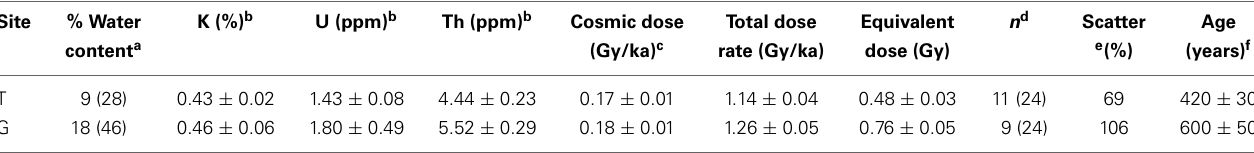
Table 3 | Quartz OSL (optical stimulated luminescence) age analyses results. Samples analyzed by the USGS, Luminescence lab, Lakewood,